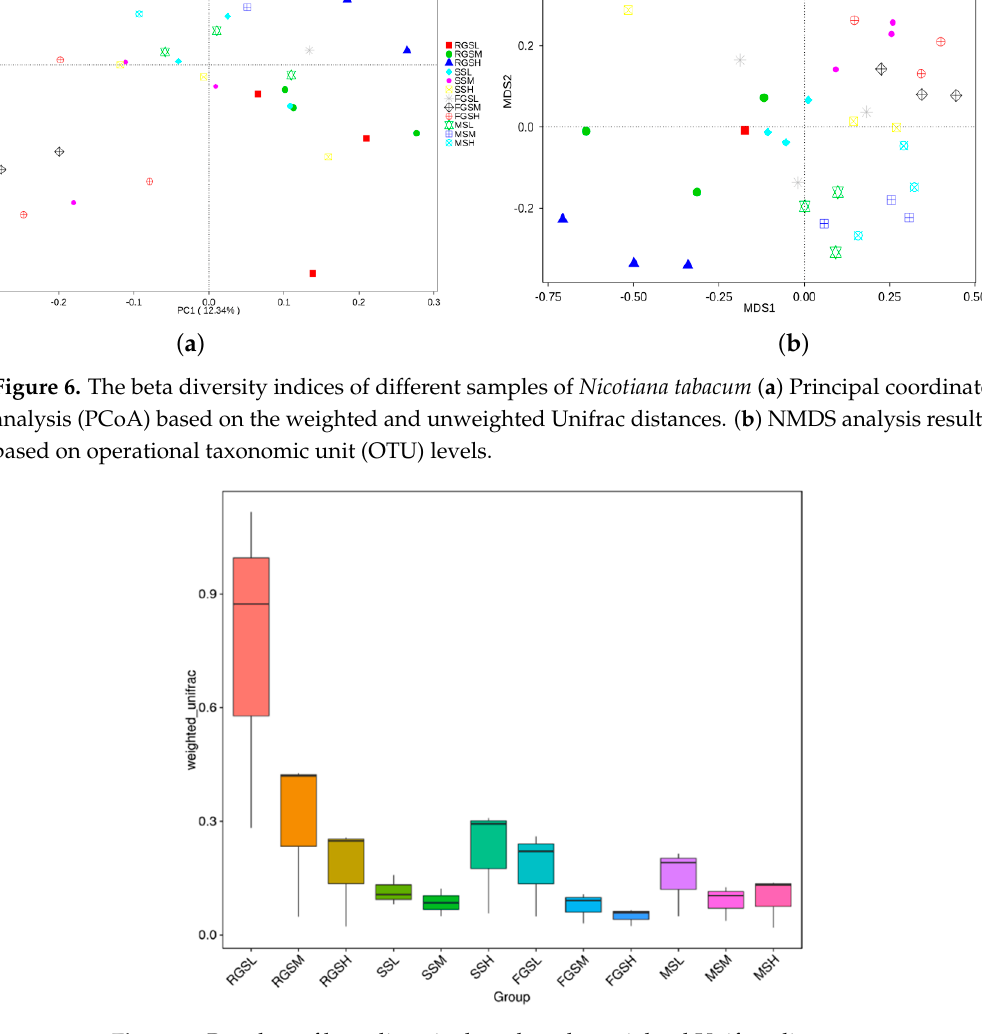
Figure 7. Boxplots of beta diversity based on the weighted Unifrac